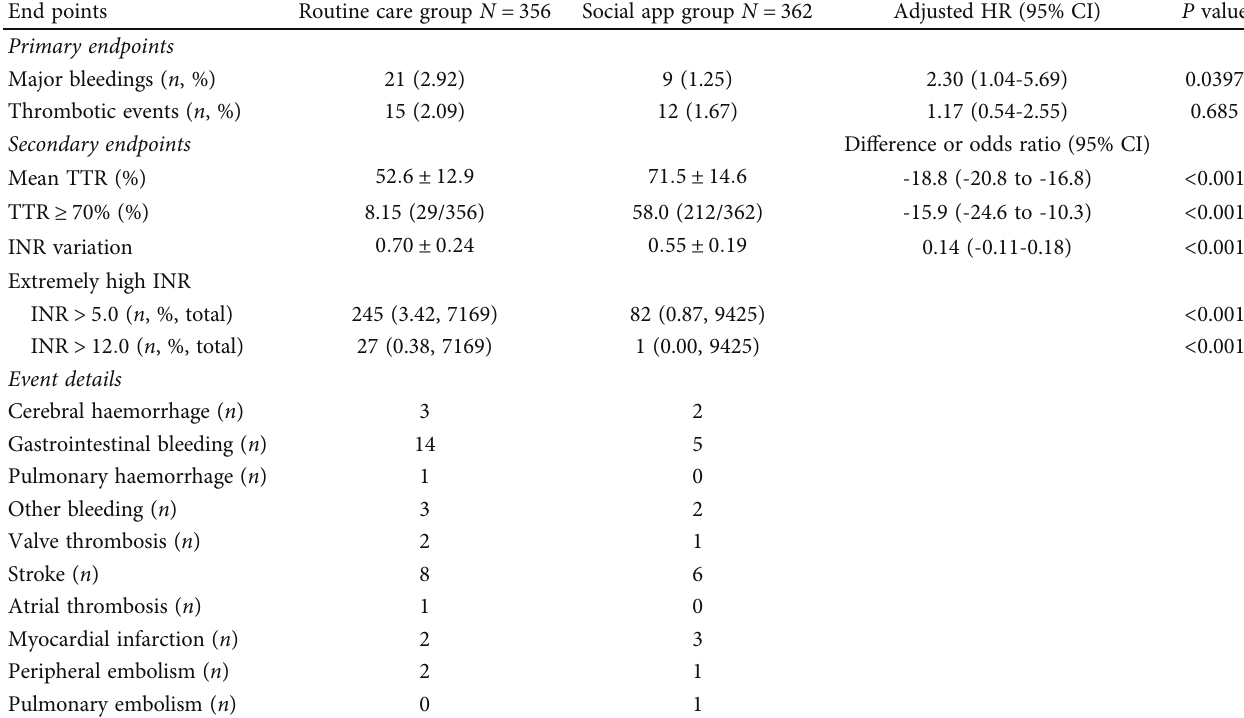
Table 2: Primary and secondary